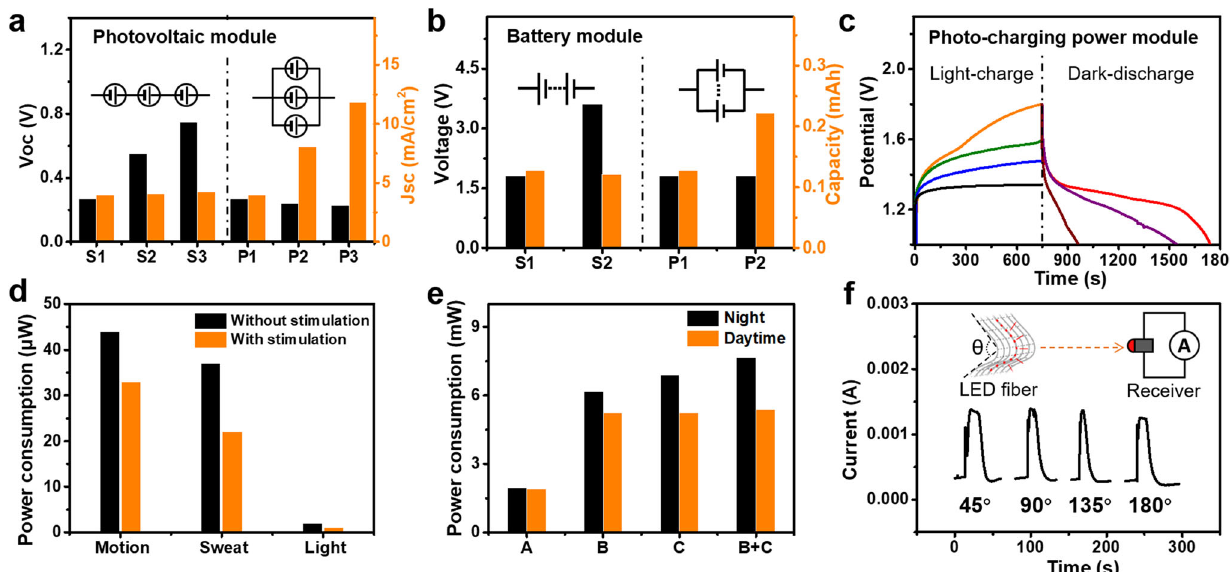
Fig. 4 Performance of the textile-type power modules. The performance of textile-type photovoltaic ( a ) /battery ( b ) module connected in series vs in parallel. c The photo-charge and dark-discharge performance by integrated textile-type photo-charging power modules. d The power consumption of different sensors without or with stimulation. e The power consumption at different stimulations in night-time or day-time: A. no stimulation, B. body moving, C. sweating. ( f ) The fabric data-sending performance at various bending